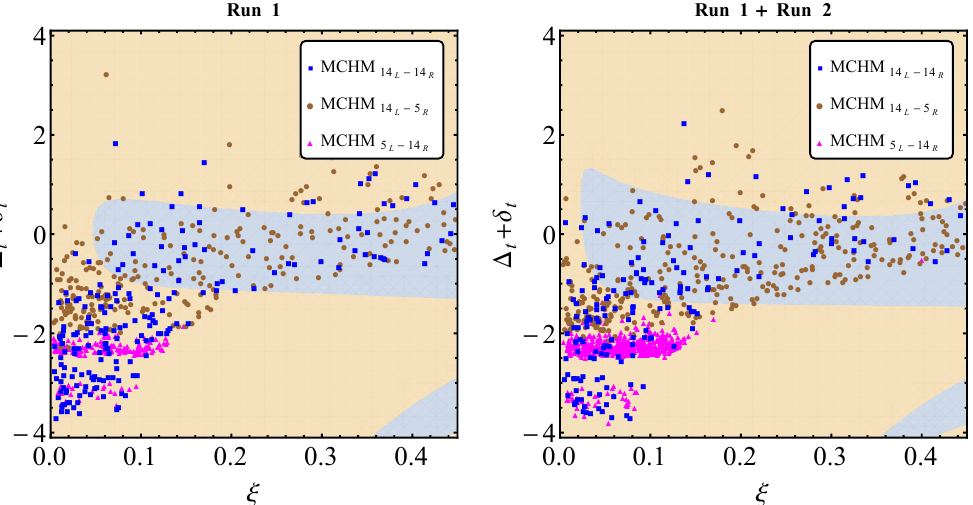
for the extended models, min . Green and yellow regions denote L (cid:0) 5 R